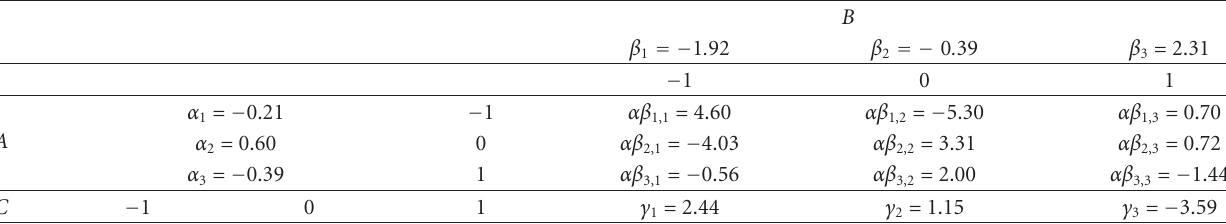
Table 10: Matrix for interaction-terms of factors A , B , C , and AB